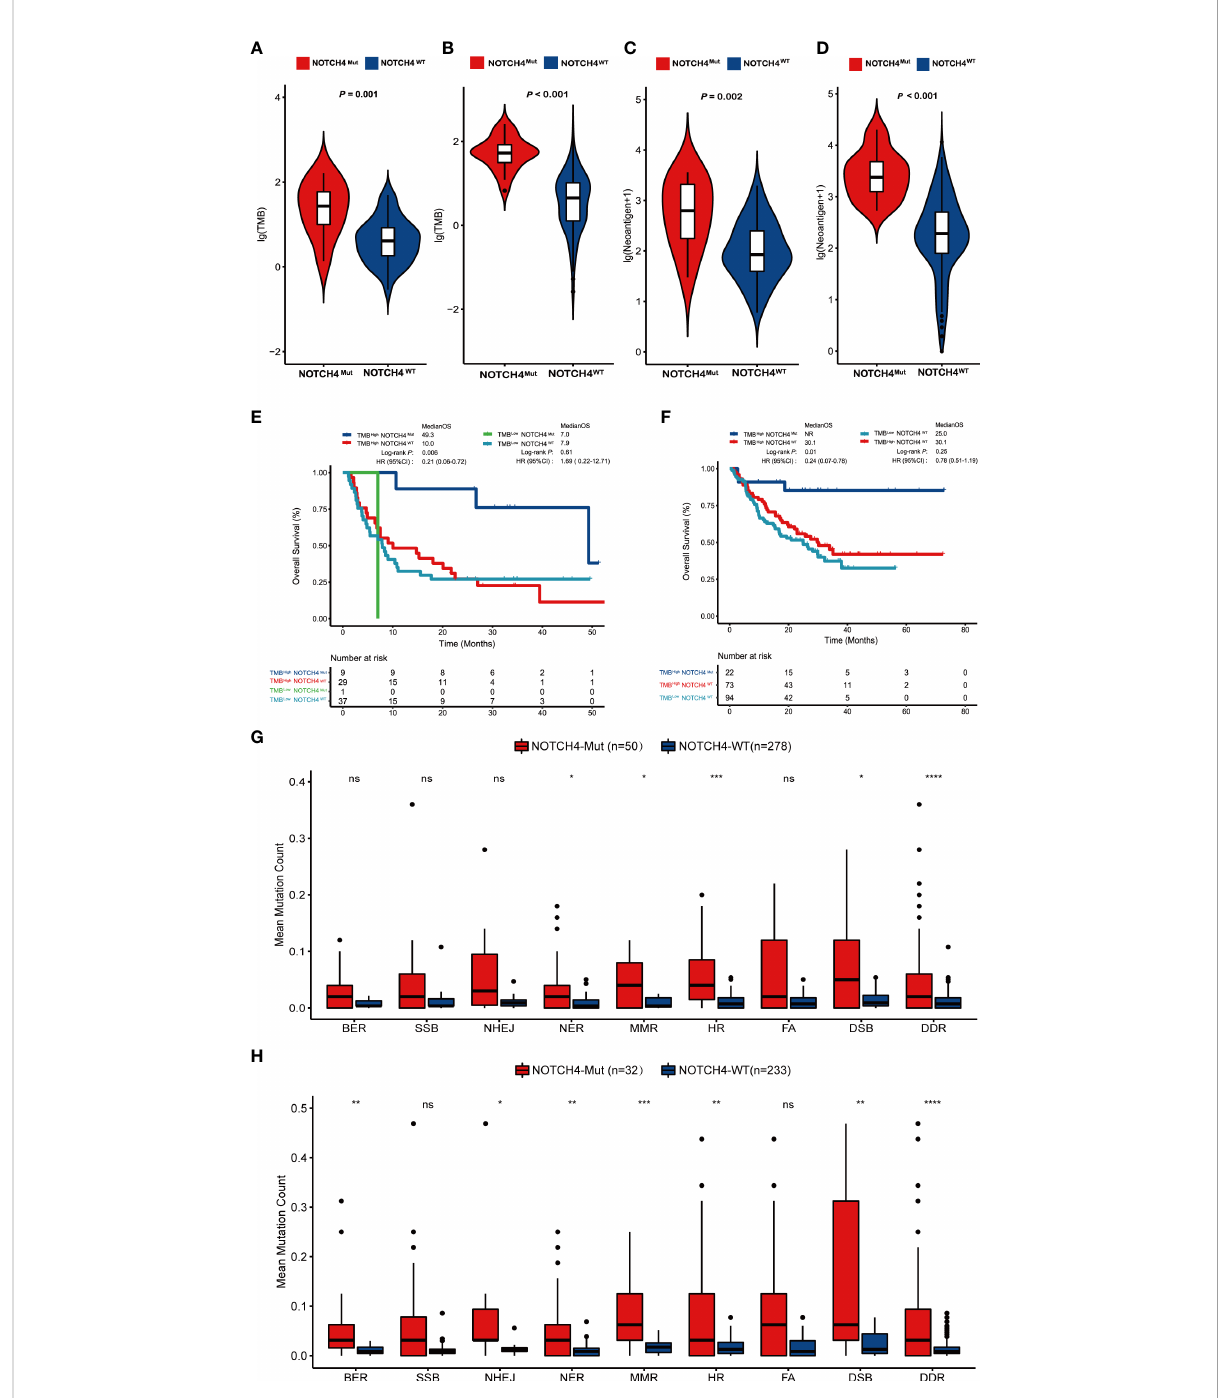
FIGURE 4 NOTCH4-Mut patients have an association with TMB and TNB. (A,B) Comparing TMB with NOTCH4-Mut and NOTCH4-Wt patients in the discovery cohort (A) and validation cohort (B) . (C, D) Comparing TNB with NOTCH4-Mut and NOTCH4-Wt patients in the discovery cohort (C) and validation cohort (D) . (E, F) The Kaplan – Meier curve comparing OS among NOTCH4 Mut TMB High , NOTCH4 Wt TMB High , NOTCH4 Mut TMB Low , and NOTCH4 Wt TMB Low group in discovery cohort (E) and validation cohort (F) . (G,H) Comparison of DNA damage-related gene set variants between NOTCH4-Mut and NOTCH4-Wt groups from the TCGA NRAS-wildtype melanoma samples (G) and the combination NRAS-wildtype melanoma of the discovery and validation cohorts (H) . BER, Base Excision Repair; SSB, Single-Strand Breaks; NHEJ, Non- Homologous End Joining; NER, Nucleotide Excision Repair; MMR, Mis-Match Repair; HR, Homologous Recombination; FA, Fanconi Anemia; DSB, Double-Strand Breaks, DDR, DNA damage response. Notes: *P < 0.05; **P < 0.01; ***P < 0.001; ****P < 0.0001; ns, P <